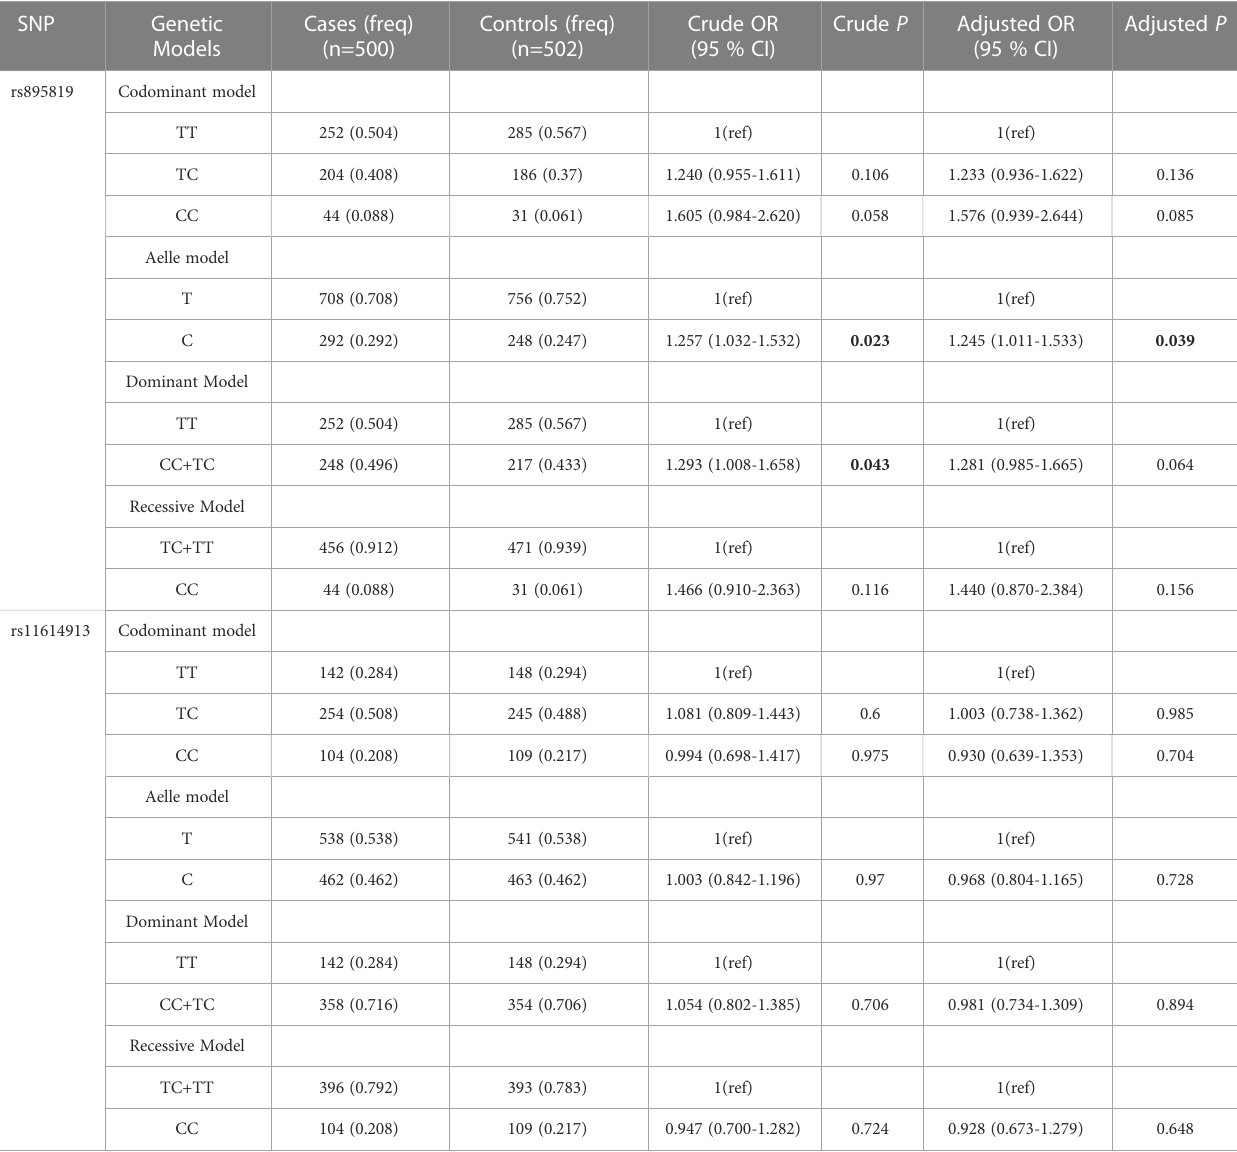
TABLE 3 The associations between SNPs and GDM risk in overall